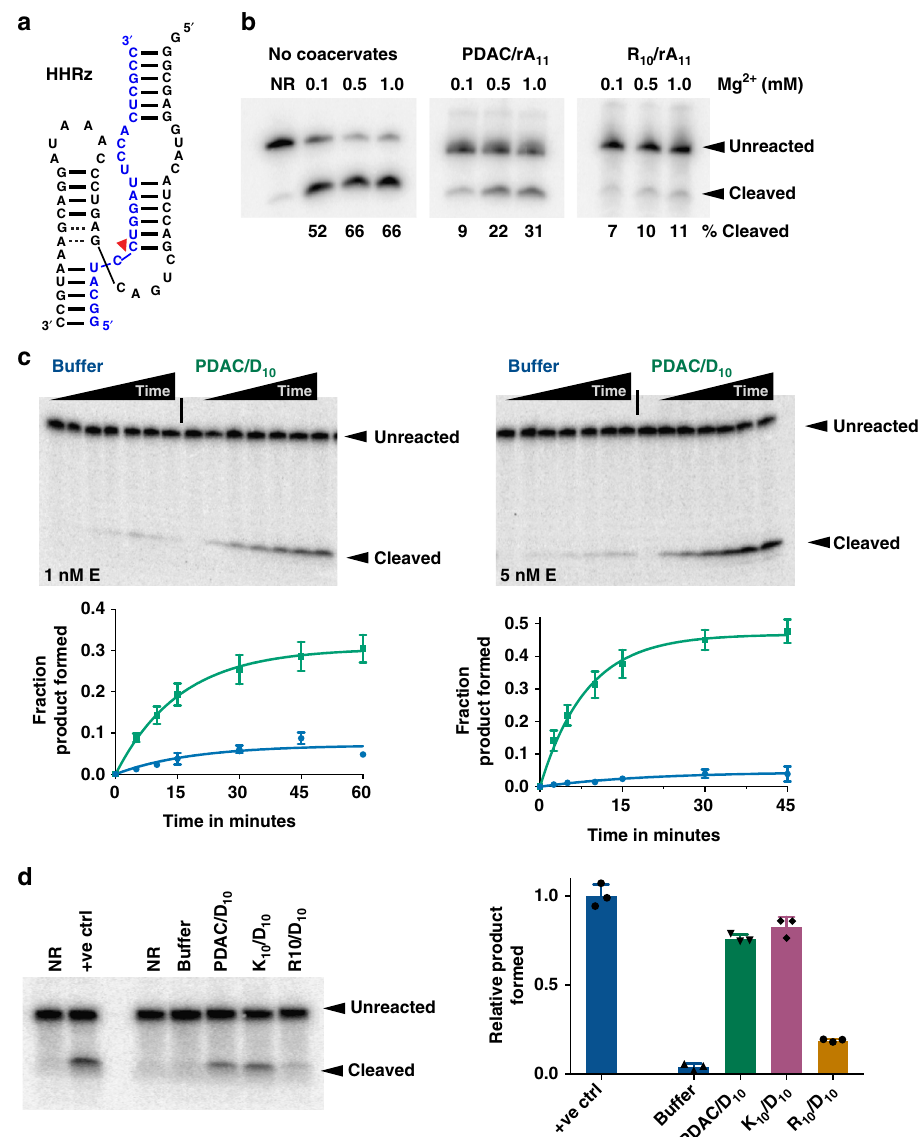
Fig. 5 Enhanced ribozyme activity in coacervates. a Structure of the hammerhead ribozyme – substrate complex. The cleavage site is indicated with red arrow. b Gel images showing ribozyme cleavage at different Mg 2 + concentrations in the coacervate phase after 1 h. Dilute and coacervate phases were separated immediately after the reaction initiation. Reactions contained 25 mM Tris·HCl pH 8.0, 5 mM NaCl and indicated Mg 2 + . c Representative gel images showing ribozyme cleavage in buffer or in PDAC-53/D 10 coacervates at 1 nM and 5 nM ribozyme concentration; data were quanti fi ed from the gels above and fi t to Eq. (1). Reactions in buffer (blue trace) and PDAC/D 10 coacervates (green trace) were performed at room temperature in 25 mM Tris – HCl pH 8.0, 1 mM MgCl 2 , and 2.5 mM KCl. For 1 and 5 nM enzyme, observed rate constants are 0.05 ± 0.02 and 0.05 ± 0.02 min − 1 for reactions in buffer and 0.06 ± 0.01 and 0.12 ± 0.01 for reactions in coacervates. d Representative gel image showing ribozyme cleavage after 1 h of reaction in 25 mM Tris – HCl pH 7.5, 1 mM MgCl 2 , and 2.5 mM KCl. NR contained no ribozyme, + ve ctrl contained 250 nM ribozyme, and all other lanes contained 2.5 nM enzyme. Coacervates contained 15 mM total positive charge from various polycations and 15 mM total negative charge from D 10. Product yields were normalized to “ + ve ctrl ” . All error bars represent S.E.M. ( n = 3) from three independent experiments. Uncropped gel images are shown in Supplementary Figure 16a,